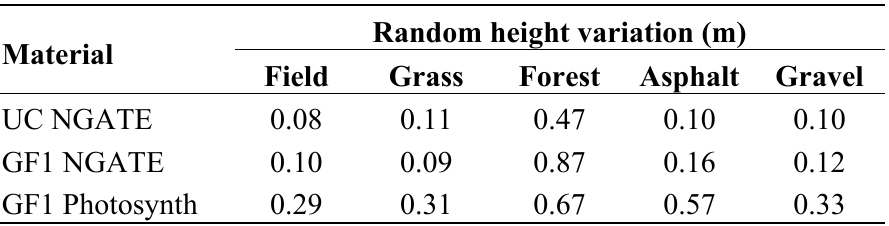
Table 4. Random height variations evaluated in different objects in 3 m × 3 m areas. UltraCamXp processing was carried out with NGATE with a 10 cm point interval and the GF1 point cloud was created using NGATE with a 5 cm point interval and using Photosynth.